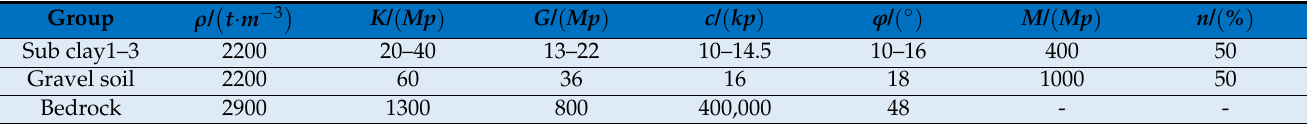
Table 2. Physical and mechanical parameters and target parameters of the landslide.